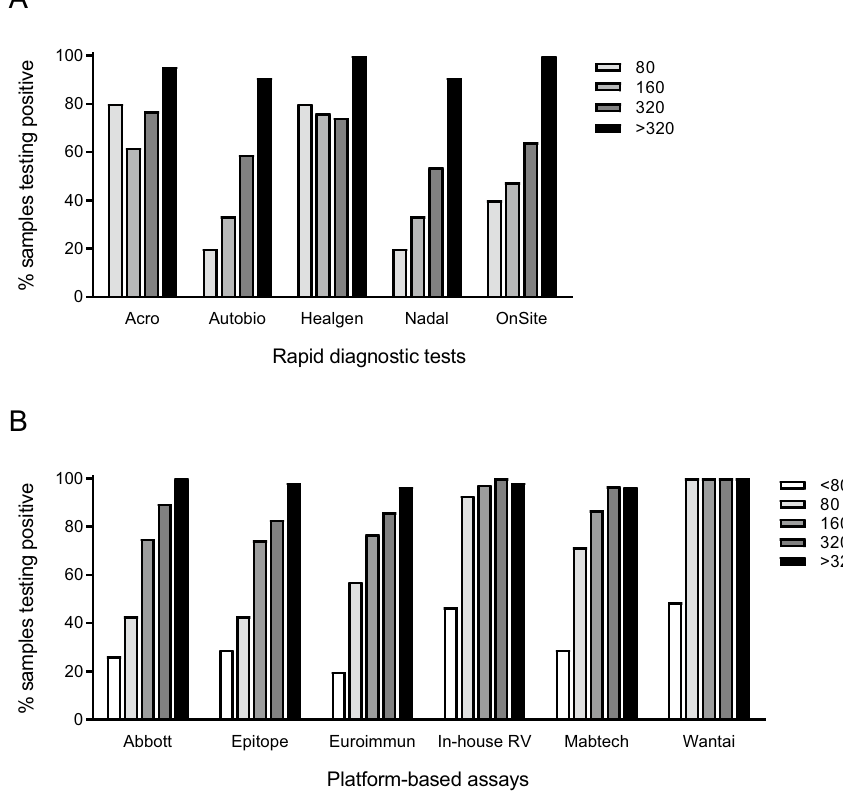
Figure 2. Performance of antibody tests assessed using samples with defined IgG antibody titers. The IgG titers, ranging from 80 to > 320, were determined using an in-house immunofluorescence assay (IFA). ( A ) The proportion of samples testing positive in rapid diagnostic IgG tests. The reference set of positive samples included 5 samples with a IgG titer of 80, 21 samples with a titer of 160, 39 samples with a titer of 320, and 22 samples with a IFA titer of > 320. ( B ) The proportion of samples testing positive in platform-based assays. Epitope, Euroimmun, and in-house RV were evaluated using 220 positive samples and Abbot, Mabtech, and Wantai were evaluated using 104, 217, and 178 positive reference samples, respectively. Among the tested reference samples, 45 tested negative at a dilution of 1:80 (< 80) using IFA, 14 samples had a titer of 80, 39 samples had a titer of 160, 64 samples had a titer of 320, and 58 samples had an IFA titer of > 320.